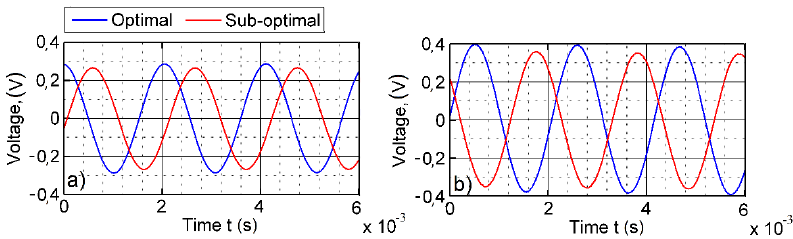
Figure 13. Open circuit voltage output for the cantilever of a constant cross-section ( 𝜔 2 = 551 Hz): ( a ) first segment; ( b ) second segment.